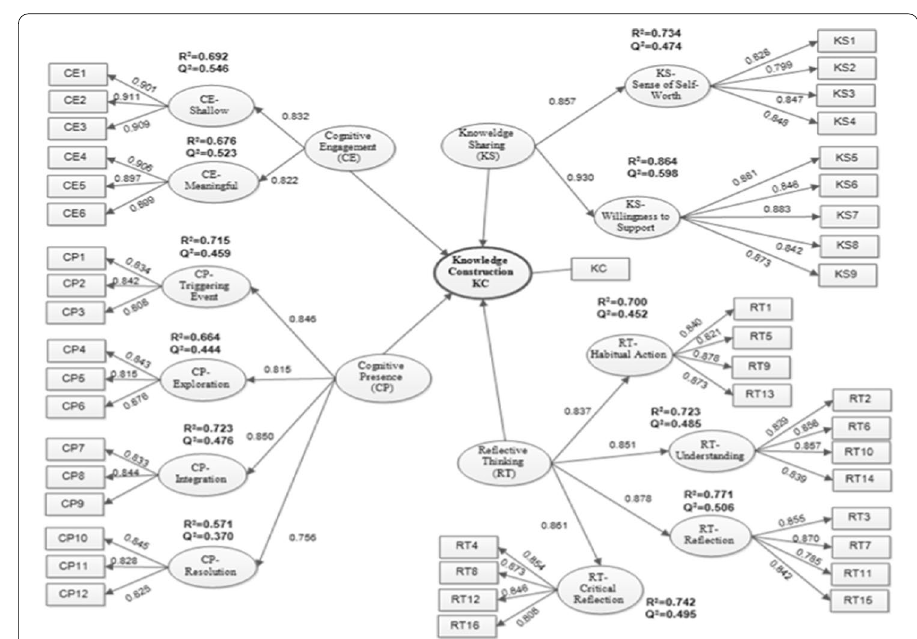
Fig. 4 Two‑stage approach PLS‑SEM model with unequal number of indicators